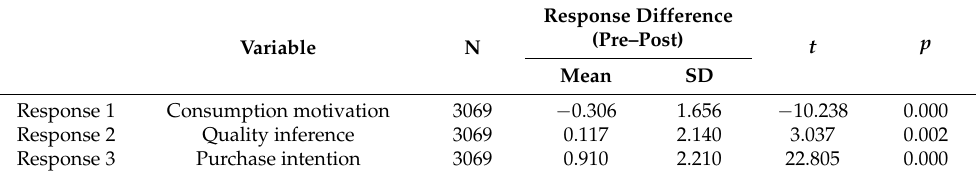
Table 7. Experts: paired t -test results for one-group pretest–posttest